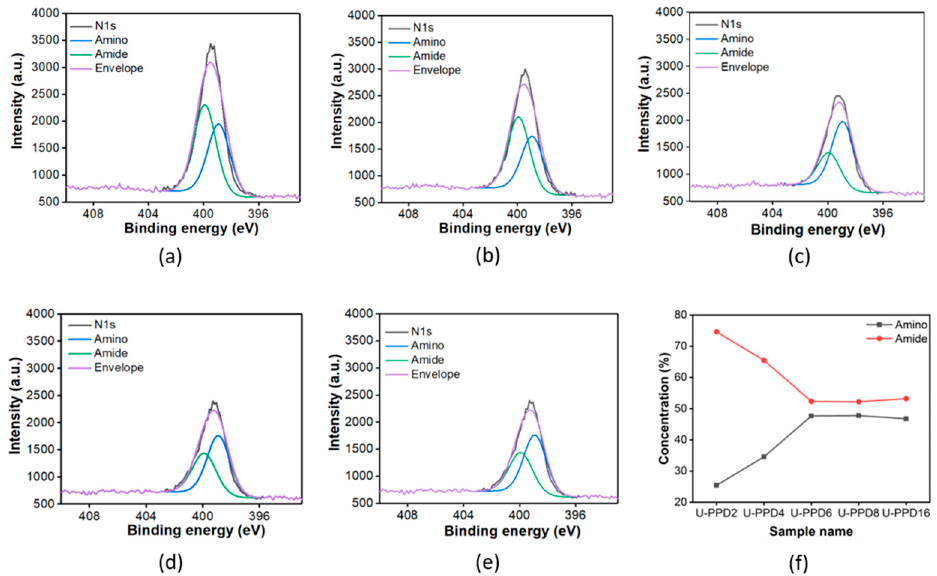
Figure 3. High resolution XPS spectra of N1s for U-PPD2 ( a ), U-PPD4 ( b ), U-PPD6 ( c ), U-PPD8 ( d ) and U-PPD16 ( e ). XPS analysis of U-PPD samples from 2 h to 16 h indicating the amino (black) and amide (red) group change with respect to the reaction time ( f ).